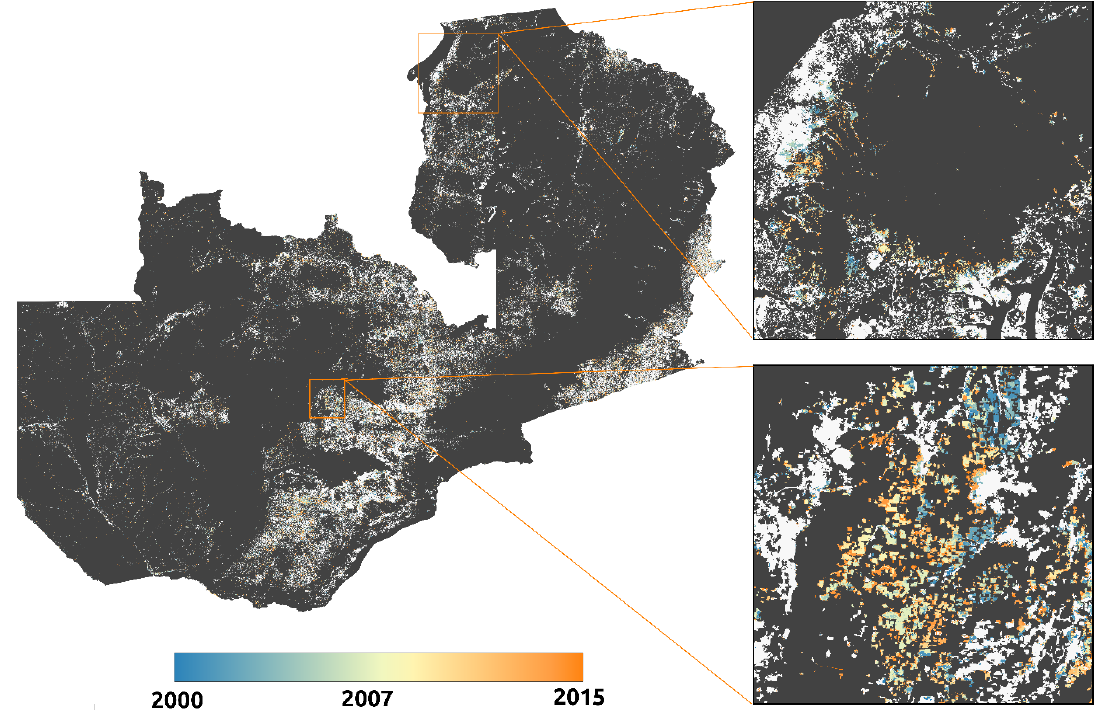
Figure 7. The areas where cropland expanded in Zambia between 2000–2015, color-coded by the year of expansion, shown in relation to cropland established prior to 2000 (white), as mapped by the GSFAD cropland layer.